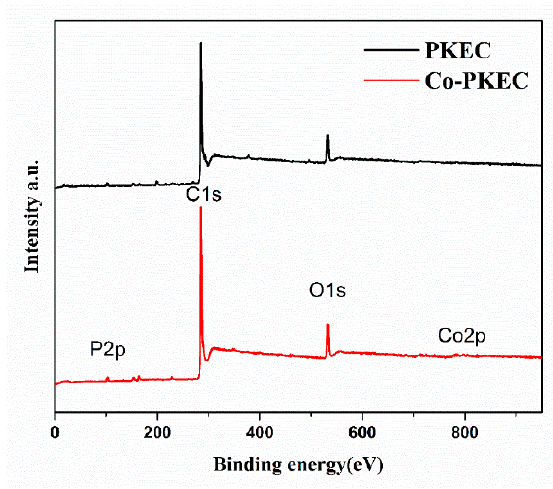
Figure 7. XPS energy spectrum of PKEC and Co-PKEC. Table 3. Composition of nitrogen elements in PKEC and Table 2. Surface chemical composition of PKEC and Co-PKEC.